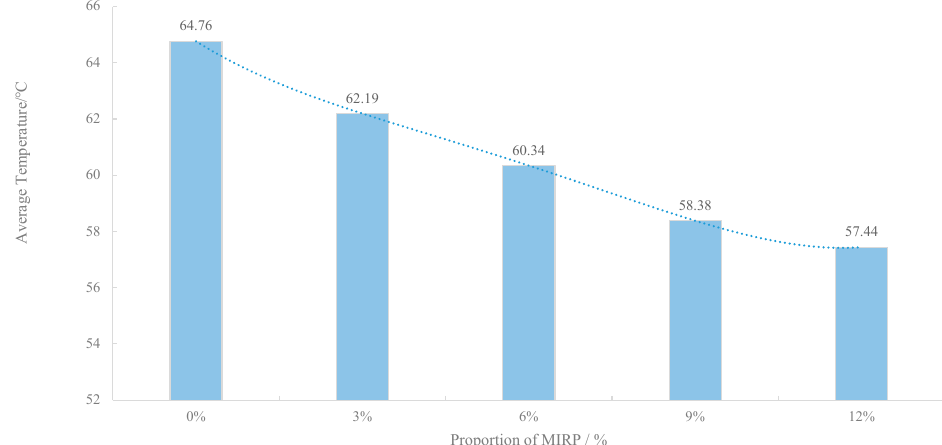
Figure 6. Equilibrium temperature of the specimens’ surface. The bottom and side insulation devices were quipped in the infrared thermal radiation test, and the bottom heat absorption of the specimen had a hysteresis relative to the surface layer, leaving the specimens in a warming state even when the radiation source was turned off. The bottom warming curves of asphalt mixture with different proportion of MIRP are depicted in Figure 7. It clearly illustrates that the bottom temperature gradually decreases with increasing infrared powder doping according to Figure 7.